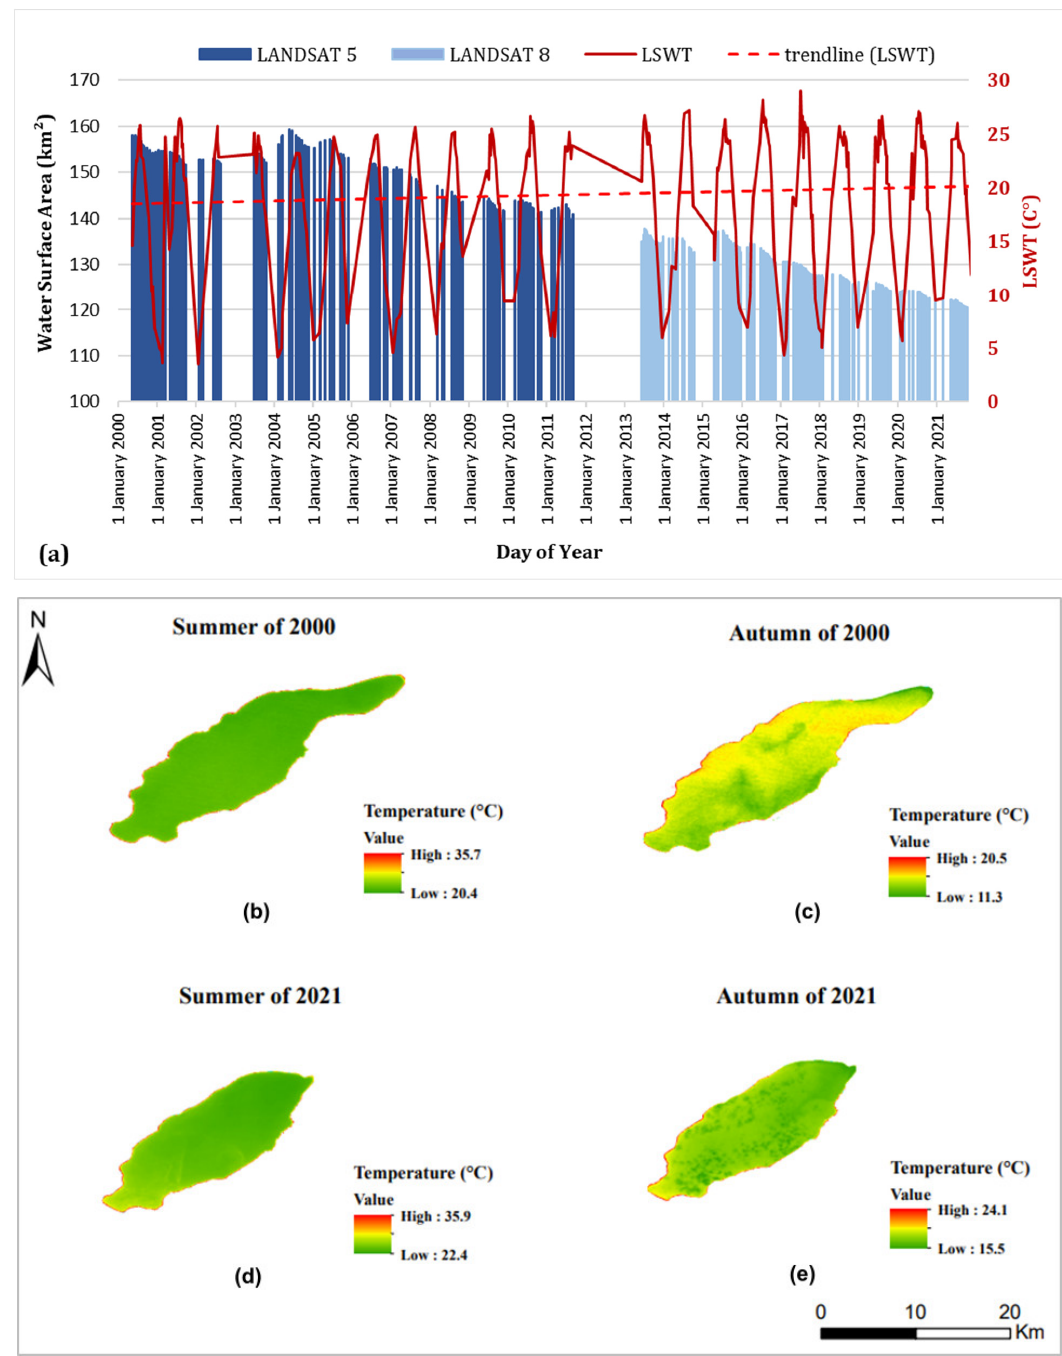
Figure 12. ( a ) The temporal changes in water extent of Burdur Lake with the LSWT variable. The spatial changes of lake’s surface area with LSWT for: ( b ) summer 2000, ( c ) autumn 2000, ( d ) summer 2021, and ( e ) autumn 2021.